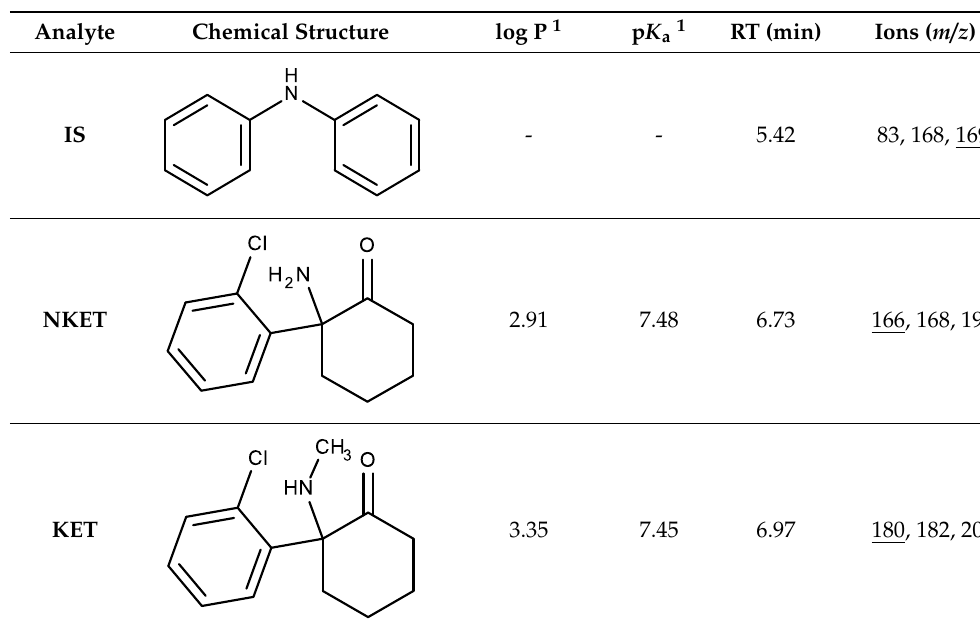
volume injection-gas chromatography-mass spectrometry operating in the selected ion monitoring mode (LVI-GC-MS(SIM)). The error bars represent the standard deviation for the recovery levels of three replicates for each parameter evaluated. The microextraction devices were designed to be used only one time, once they are inexpensive and in order to avoid carryover effects [17]. Table 1. Chemical structures, octanol-water partition coefficients (log P) and acid dissociation constants (p K a ), as well as retention times (RT) and ions ( m/z ) of KET and NKET obtained by LVI-GC- MS(SIM), under optimized instrumental conditions. Chemical Structure RT (min) Ions ( m / z ) 2